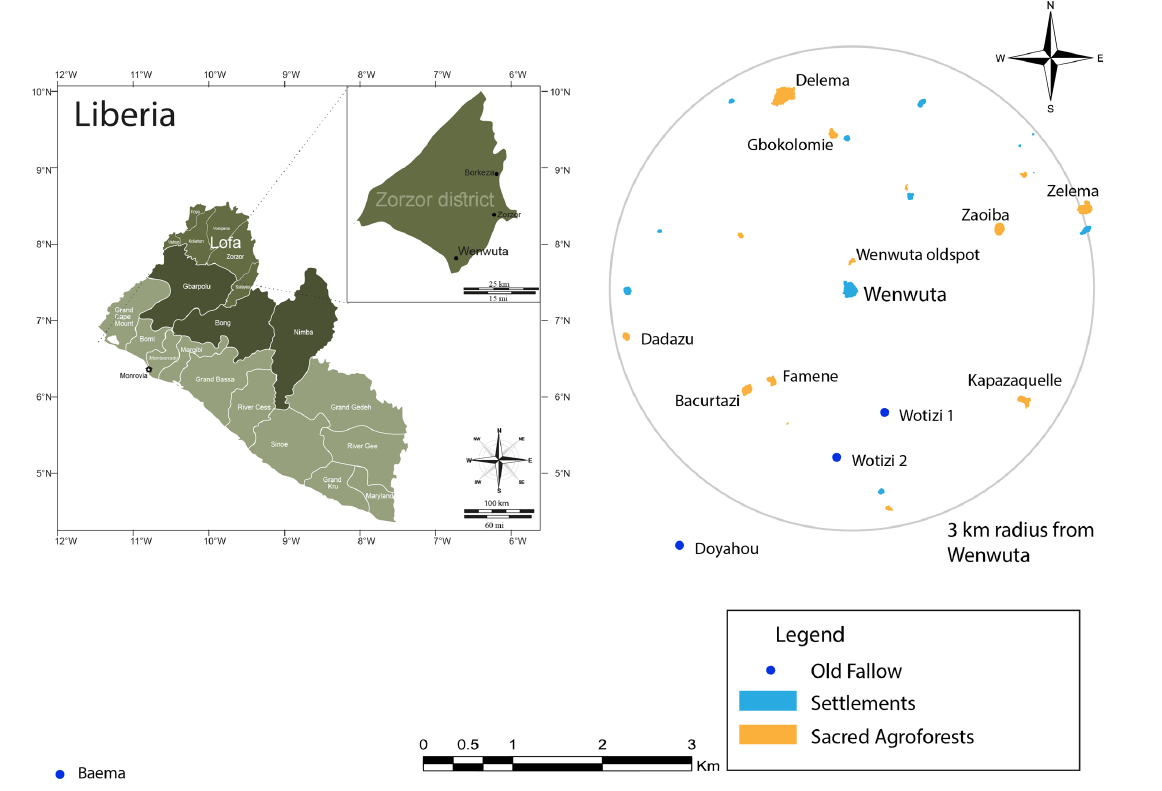
Fig. 1 . Location of Wenwuta in Liberia (inset top left), and the sacred agroforests and old fallows sampled in the vicinity of Wenwuta. The areas of sacred agroforests and settlements were mapped with GPS in collaboration with local